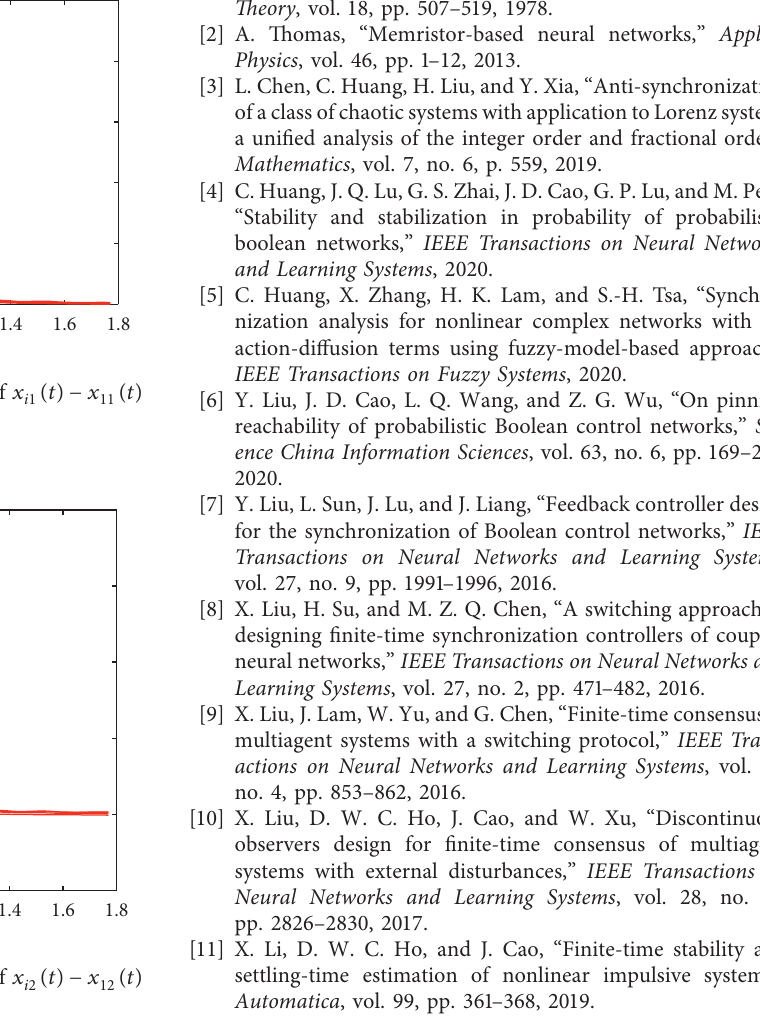
Figure 3: The synchronization error trajectories of x in Example